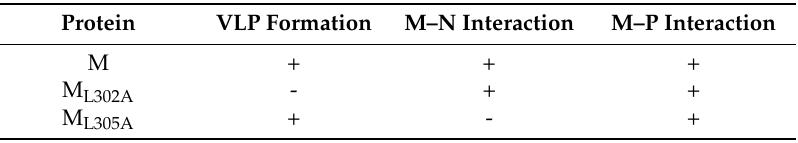
Table 1. Properties of M and M mutants [21,22].